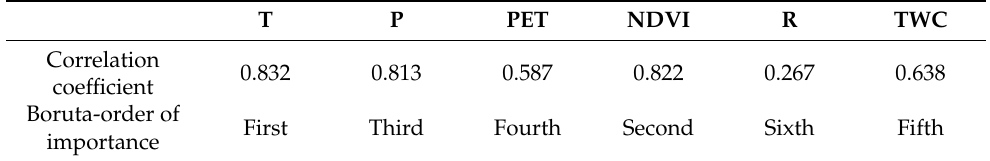
Table 3. Assessment of the P-correlation and determinant order of monthly average AET in South America. T P PET